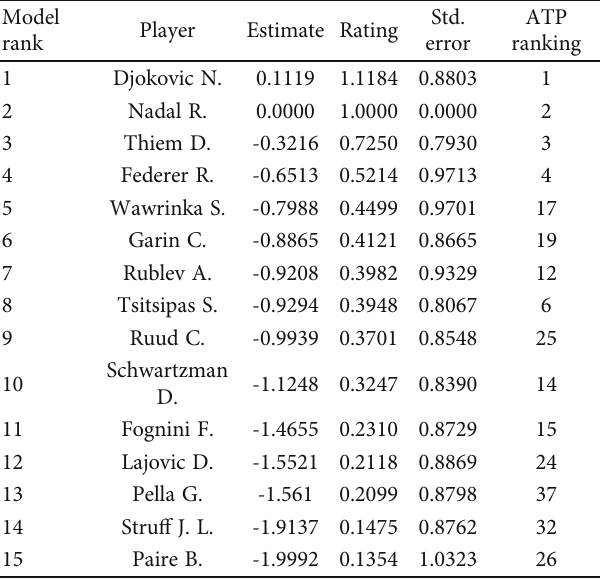
Figure 6: Match by match comparison of predicted probability with implied probability from bookmakers ’ average and best odds on hard court. Table 5: Model ranking and ATP ranking of top 15 players on clay